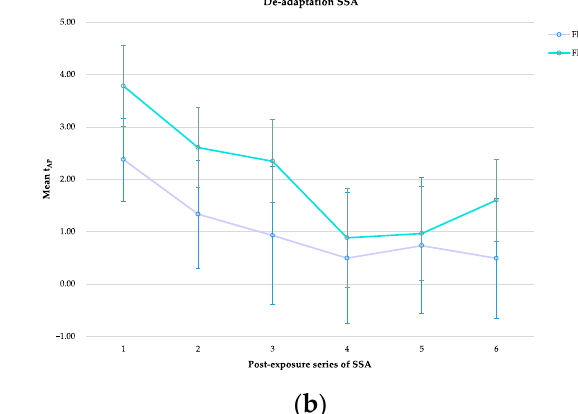
Figure 6. The graphic shows the time gradient of prismatic adaptation (t AP ) means (±SE) in the nine sets of visible pointing (VP) for fi eld dependent (FD) and fi eld independent (FI). Second, we tested whether there were any di ff erences in how FI/FD extinguished PA.